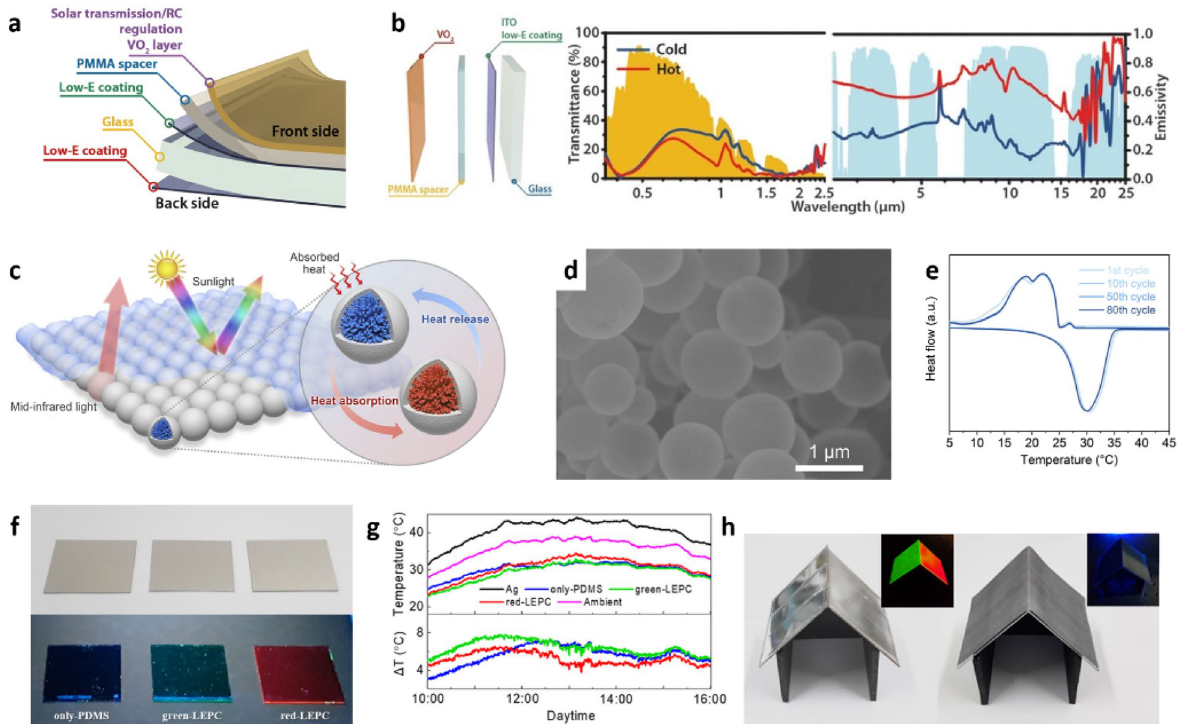
Fig. 7 a Schematic structure and b spectral transmissivity and emissivity of VO 2 smart window. Reproduced with permission from [110]. Copyright 2021, Science. c Schematic diagram, d SEM image, and e thermal cycling performance of SiO 2 -PCMs MPs. Reproduced with permission from [114]. Copyright 2022, Cell Press. f Photos of various RC devices under indoor light (upper) and UV lamp (below). g Daytime outdoor temperature and difference between ambient temperature and device temperatures. h Artificial houses equipped with a light-emitting cooling roof and conventional roof. Reproduced with permission from [116]. Copyright 2020, American Chemical